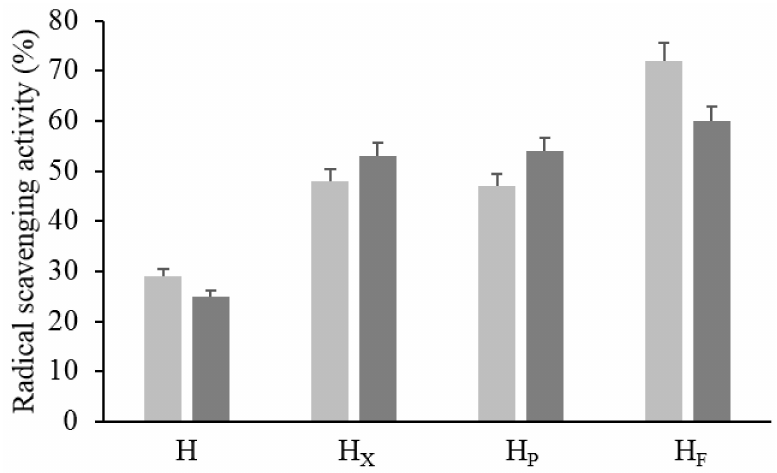
Figure 4. Radical scavenging activity (RSA) of raw and bioprocessed hemp. H, untreated hemp dough; H X , hemp dough treated with xylanase Depol 761P (1% wt / wt of fiber); H P , hemp dough treated with protease VeronPS (2.5% wt / wt of protein); H F , hemp dough fermented by Lactiplantibacillus plantarum 18S9 and Leuconostoc mesenteroides 12MM1 (ratio 1:1, final cell density of circa 7 log10 cfu / g). All treated samples were incubated at 30 ◦ C for 24 h. RSA was determined in the methanolic (light grey) and water / salt (dark grey)